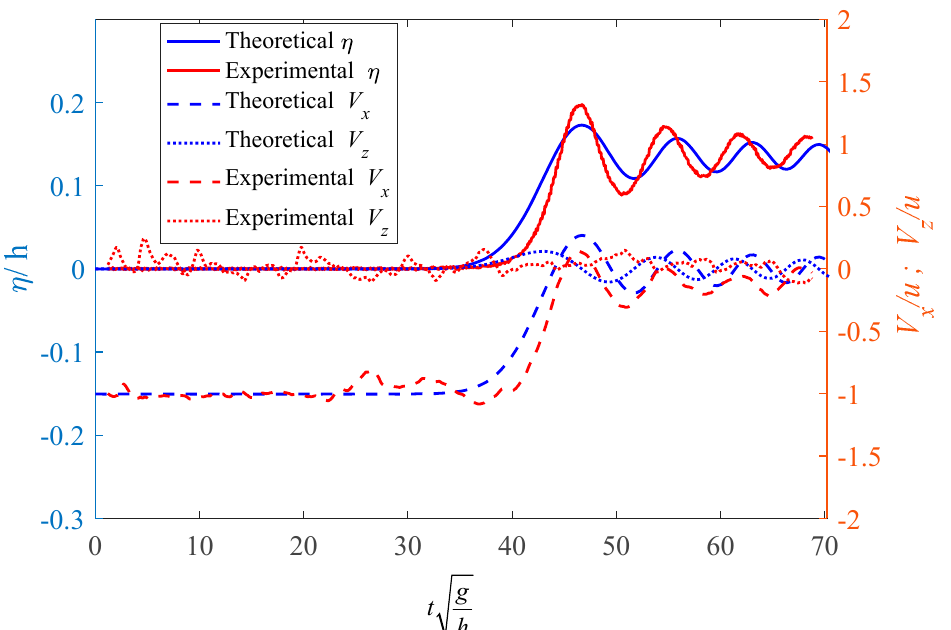
Figure 4. Comparisons of surface elevation, horizontal velocity, and vertical velocity.